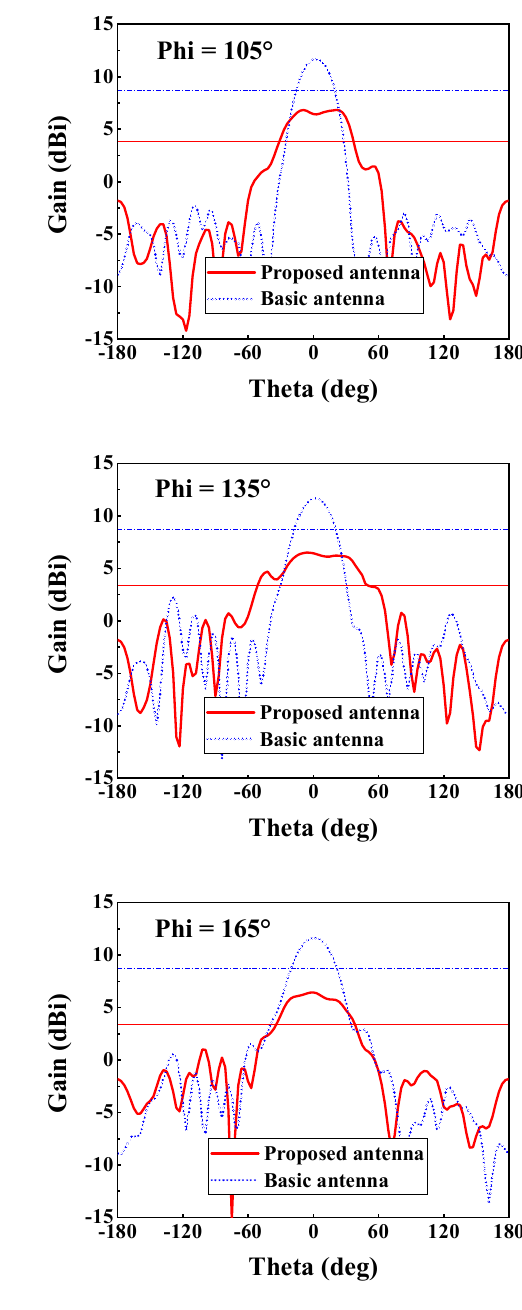
Figure 3. Simulated gain results of the proposed wide−beam antenna and basic ALTSA in different cut−planes.